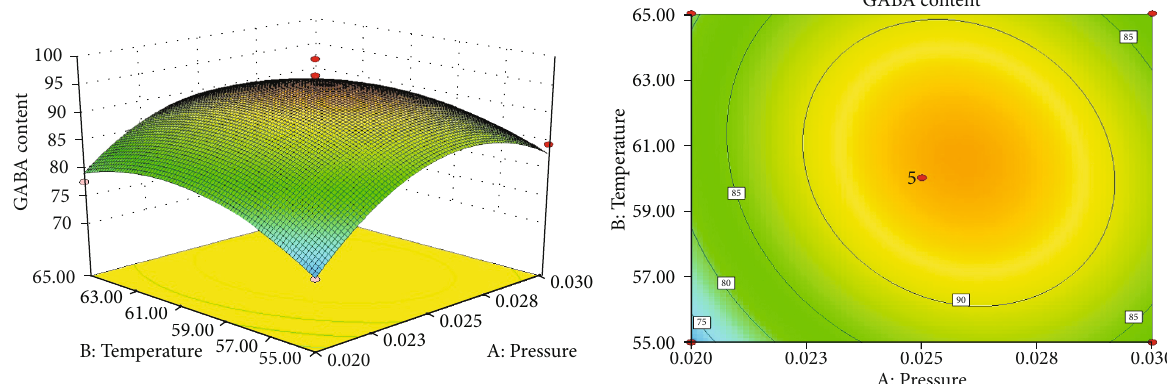
Figure 6: Response surface and contour diagram of pressure and temperature in fl uence on GABA content.